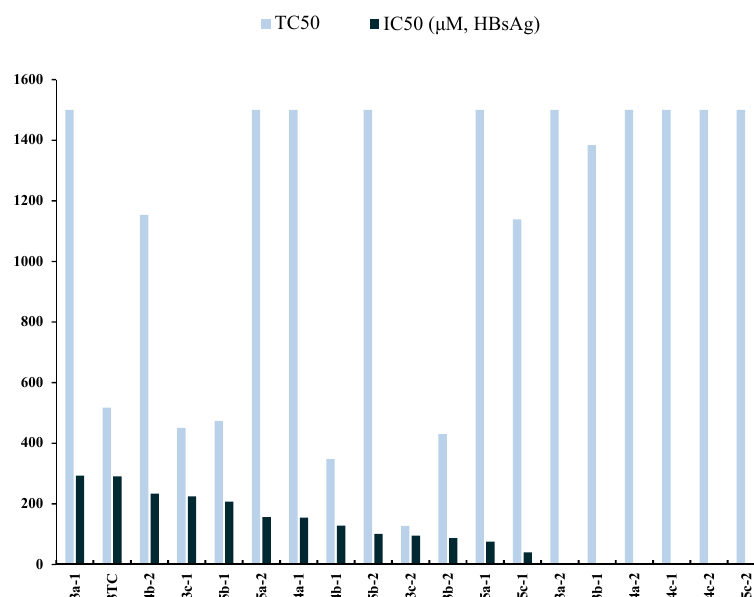
Figure 5. Cytotoxicity and inhibiting HBsAg activity of compounds in 9 days.